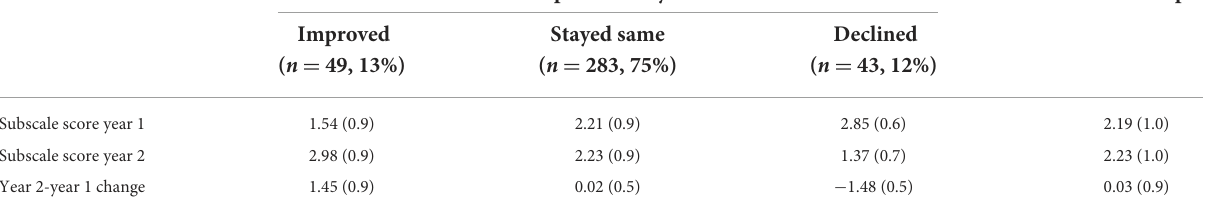
TABLE 2 Results for social relations subscale.